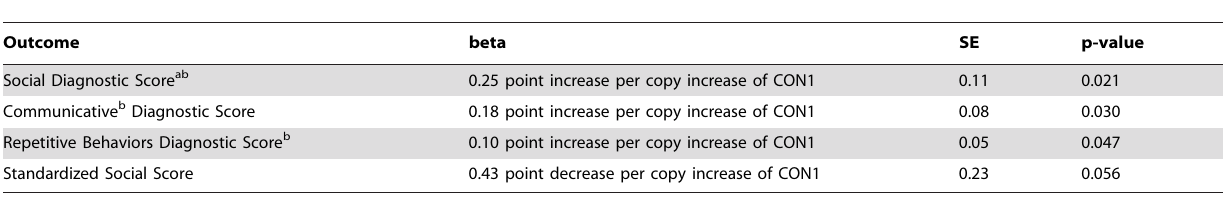
Table 1. Results from multivariate regression analyses.